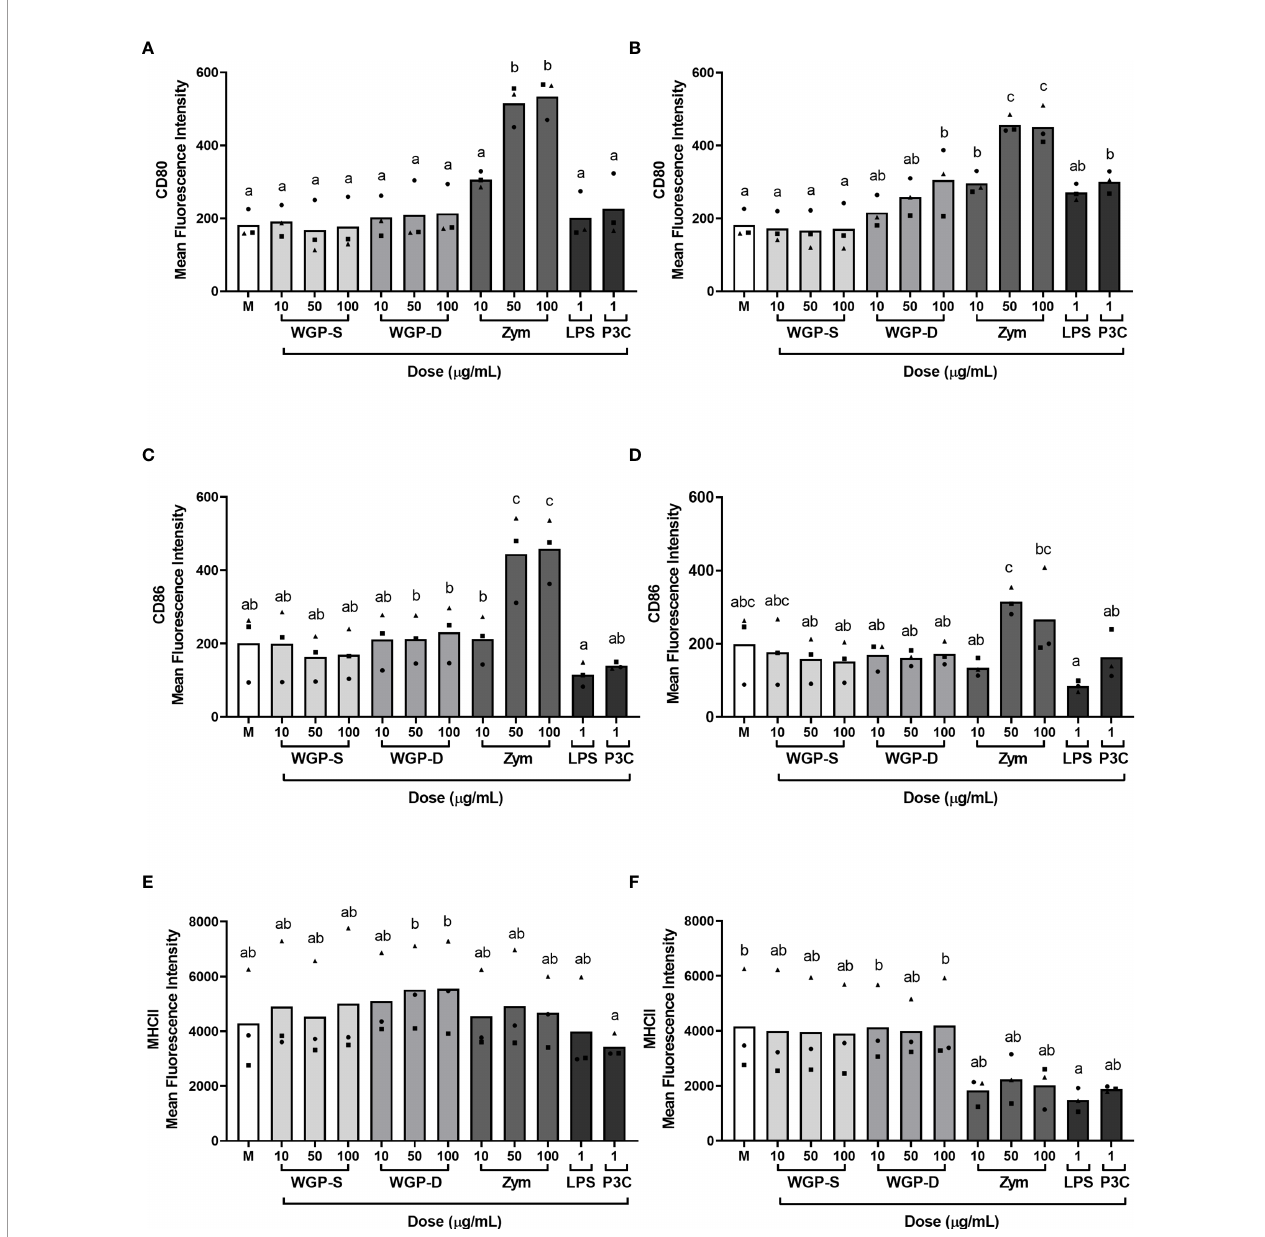
FIGURE 4 | Expression of (A, B) CD80, (C, D) CD86, and (E, F) MHC class II molecule expression on the cell surface of bovine monocytes stimulated with WGP Soluble (WGP-S), WGP Dispersible (WGP-D), Zymosan (Zym), LPS, and Pam3csk4 (P3C) for 8 h (A, C, E) or 16 h (B, D, F) , as evaluated by fl ow cytometry. Results correspond to means of the mean fl uorescence intensities for each analyzed molecule of three independent biological samples (each represented by squares, triangles or circles). a,b,c Means with different superscript letters are signi fi cantly different ( P